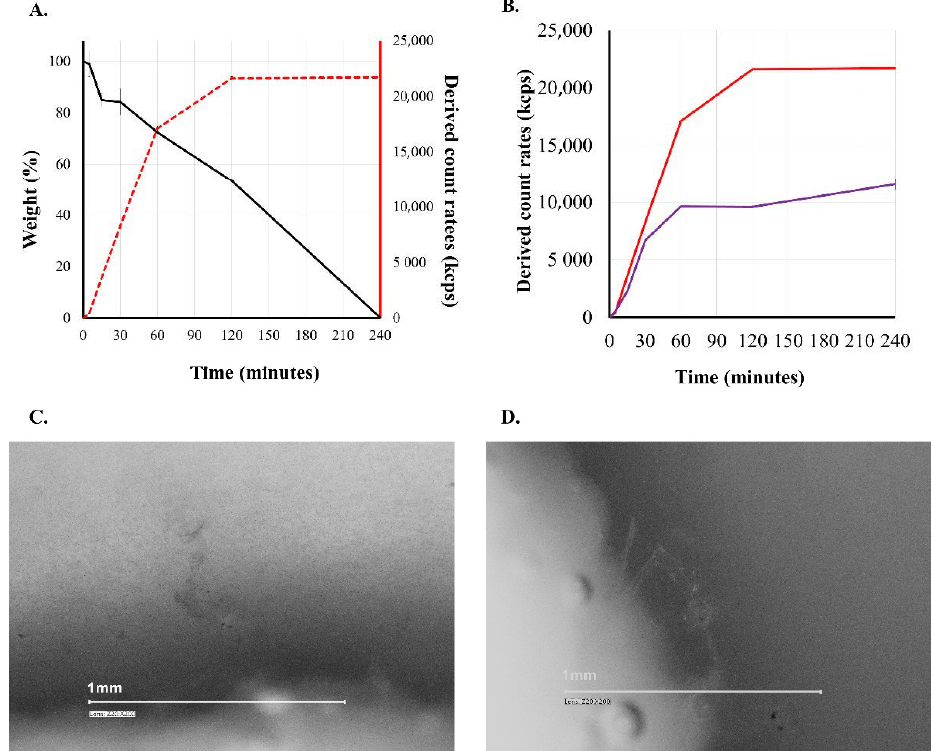
Figure 3. Erosion of PVA-based carrier ( A ): black line—weight loss; red line—pH = 1.2 HCl; ( B ): red line—pH = 1.2 HCl; violet line:—pH = 6.8 phosphate buffer (carrier = PVA; n = 3; mean ± SD). ( C , D ):